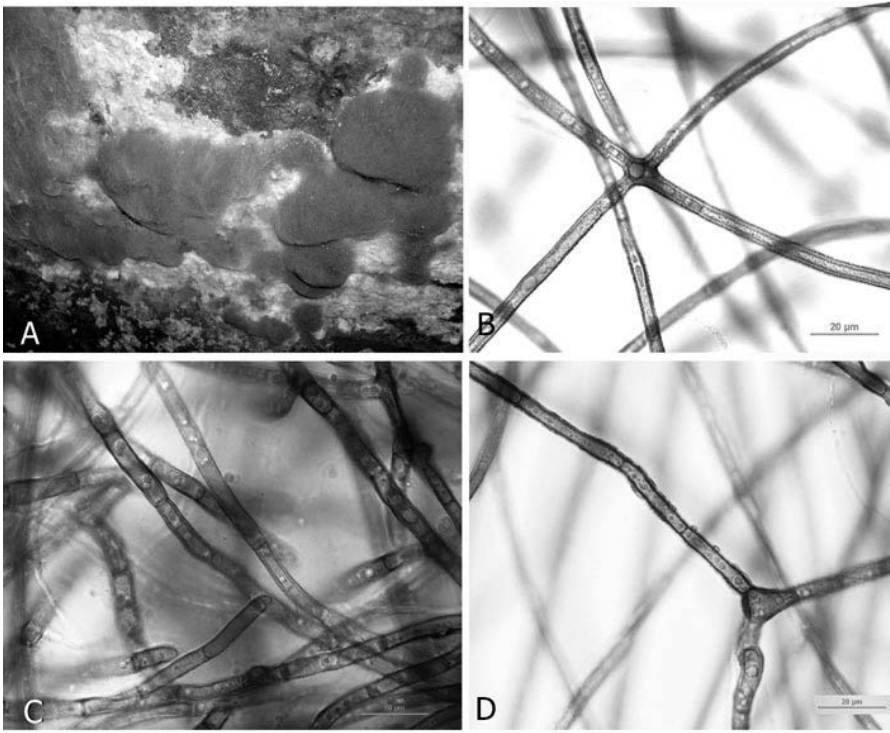
Fig. 1. Zasmidium cellare in the brandy maturation cellar of the ‘Polmos’ manufacture in szcze-szcze- cin, Poland: A – colonies on rock wall; b – verrucose hyphae; C – young hyphae; d – encrusted hyphae. Scale bar for B, C, D = 20